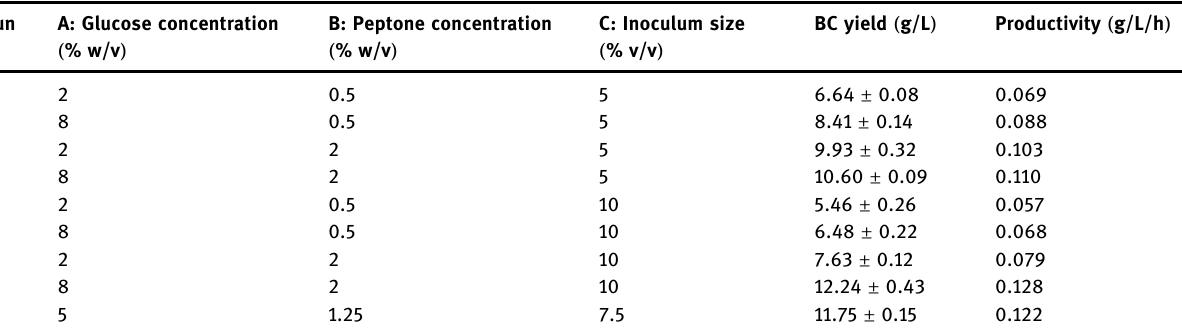
Table 3: The e ff ect of di ff erent glucose and peptone concentrations, as well as di ff erent inoculum sizes, on the yield of BC produced by P. kudriavzevii USM - YBP2 using a two - level factorial experimental